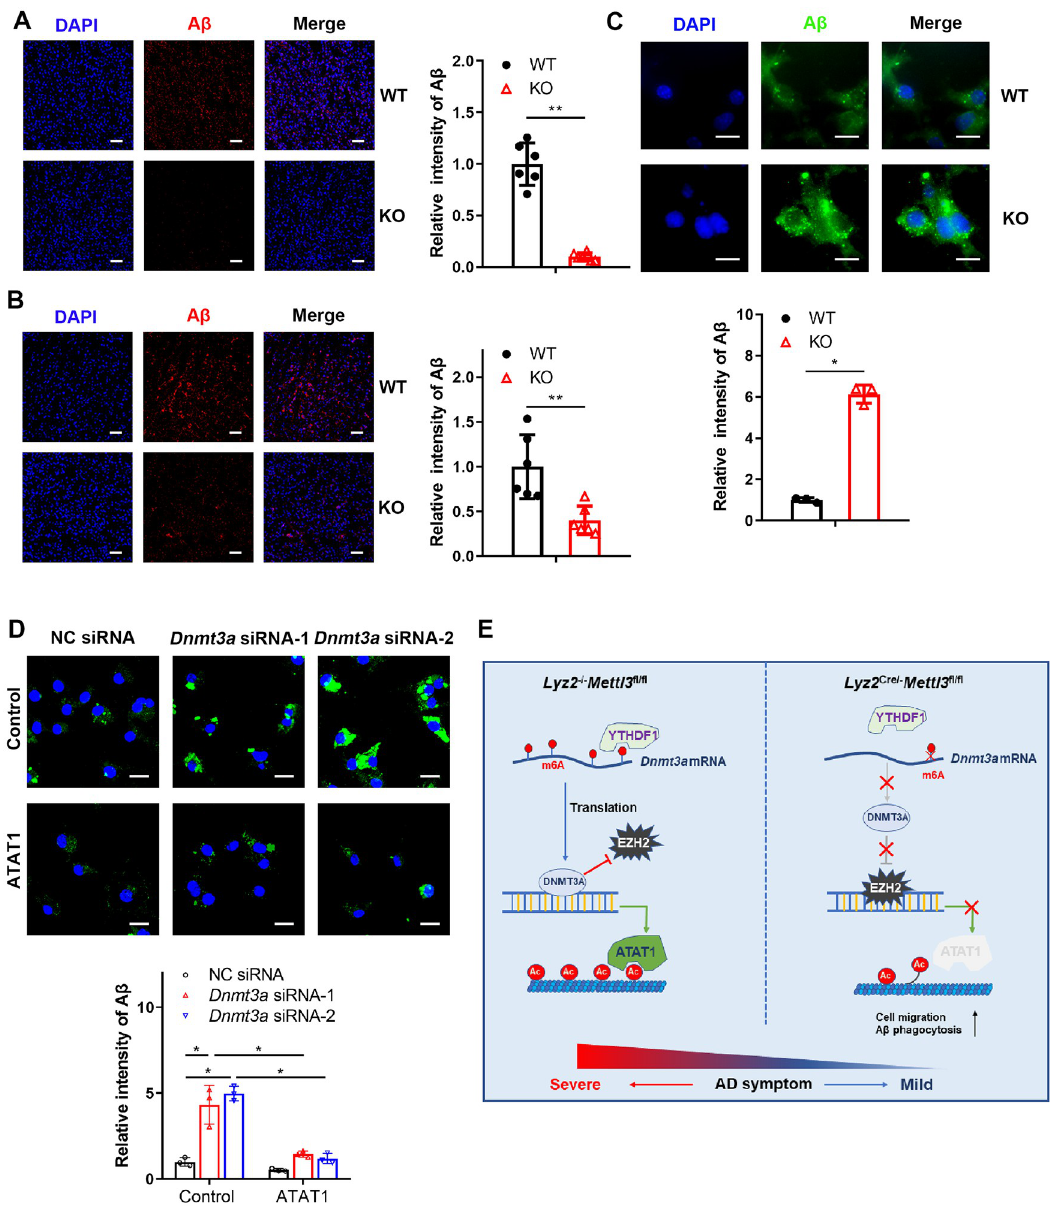
Fig 7. METTL3 deficiency enhances A β uptake. (A) Representative fluorescence micrographs of brains from A β -injected WT and KO mice, immunolabeled for anti-A β . Scale bars: 50 μ m. (B) Representative fluorescence micrographs of brains from the KO (24 months old) and age-matched WT mice, immunolabeled with A β antibody. Scale bars: 50 μ m. (C) Representative fluorescent micrographs and quantitative analysis of A β uptake in WT or KO BMDMs stained with A β antibody. Scale bars: 10 μ m. (D) Representative fluorescence micrographs and quantitative analysis of A β uptake in the ATAT1-overexpressing THP1 cells transfected with NC siRNA or Dnmt3a siRNA. Scale bars: 10 μ m. (E) Schematic diagram of the role of the m6A writer METTL3 in AD. All data in the figure are shown as the mean ± SD. P < 0.05 ( � ), P < 0.01 ( �� ). Underlying data can be found in S1 Data. A β , amyloid beta; AD, Alzheimer’s disease; BMDM, bone marrow-derived macrophage; KO, knockout; NC, negative control; WT, wild